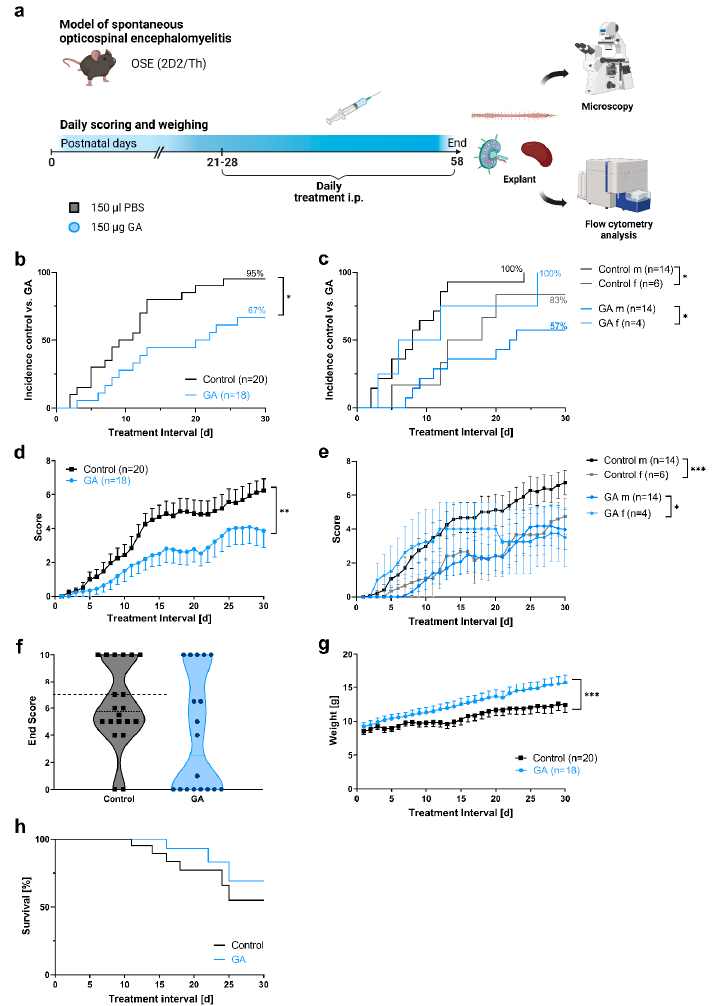
Figure 1. GA positively attenuates disease progression in OSE without effect on survival. ( a ) Overview of the experimental layout (created with Biorender.com). Animals were randomly assigned into either the GA treatment group (blue circles) or the PBS control group (black squares). ( b ) OSE incidence was higher in the control group compared to GA-treated OSE mice ( p < 0.05). ( c ) Male control mice had a higher incidence of OSE compared to female mice ( p < 0.05), whereas in female mice, the incidence was higher in GA-treated mice compared to controls ( p < 0.05). ( d ) GA treatment positively attenuated the clinical signs as measured using the EAE score ( p < 0.01). ( e ) In the control group, males had a higher score than females ( p < 0.001). In the GA group, the scores of female mice were higher ( p < 0.05). ( f ) The overall lower disability under treatment was reflected in a 2.3 point lower end score of GA-treated animals after 30 days (mean score of 3.9 in the GA group versus mean score of 6.2 in the control group) and more animals with a score of 0 in the GA group (n = 8/18) compared to the control group (n = 2/20). The interrupted line represents the cut-off following which mice were sacrificed due to animal care guidelines. ( g ) GA-treated animals had a higher body weight than control mice ( p < 0.001). ( h ) General survival did not differ significantly between both groups. Control group n = 20; GA n = 18. Data were analyzed using non-parametric two-tailed Mann–Whitney U test and are expressed as mean ± SEM; * p < 0.05; ** p < 0.01; *** p <